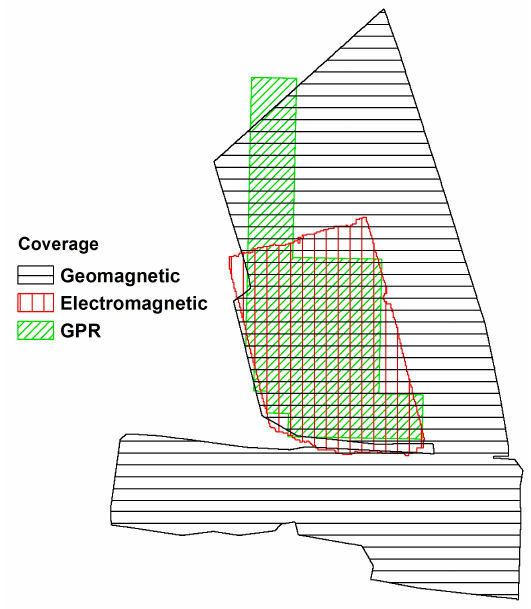
Figure 23. The overlay for the prospection coverage by different methods at Perivlepto/Kastraki 2.